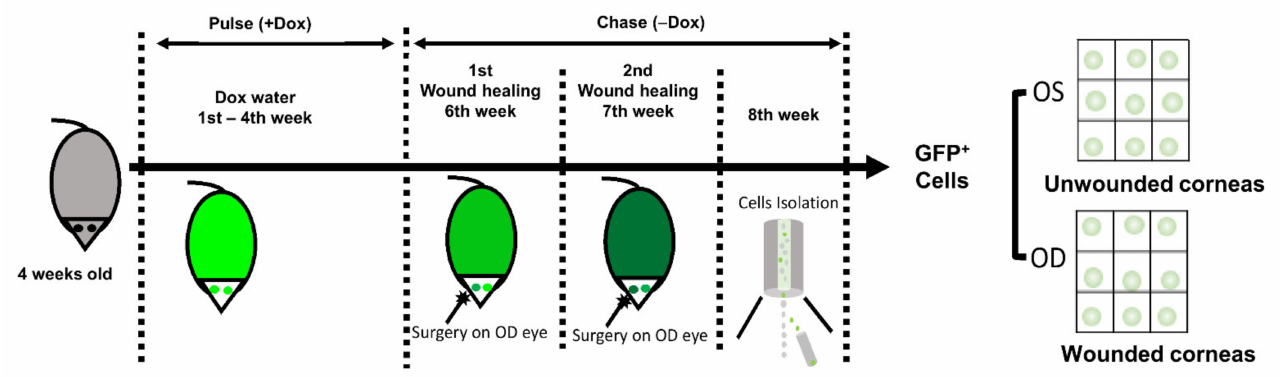
Figure 1. Experimental design of the wound-healing procedure performed on H2B-GFP mice to obtain the label-retaining cells in limbal epithelium. The 4-week-old H2B-GFP mice were fed with doxycycline (2 mg/mL) in sucrose water for 4 weeks during the pulse phase, followed by 2 rounds of corneal epithelial wound-healing procedure during the subsequent 4-week chase phase. At the end of the 8 weeks, unwounded eyes (OS eyes) and wounded eyes (OD eyes) were collected and their limbal epithelial and anterior stromal cells were collected respectively for flow cytometry to obtain the label-retaining GFP+ cells for single-cell RNA